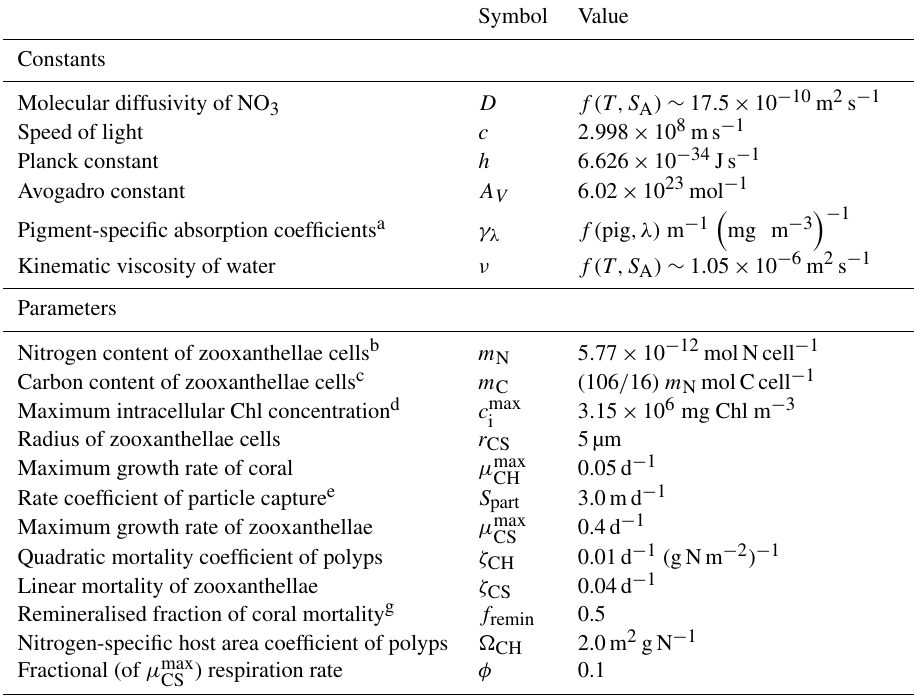
Table 30. Constants and parameter values used to model coral polyps. V is zooxanthellae cell volume in µm 3 .